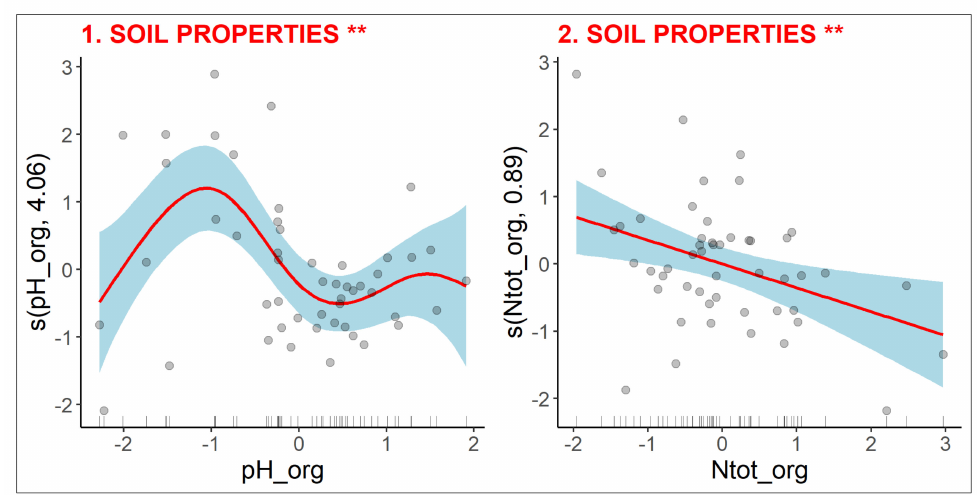
Figure 7. The estimated relationships between the diversity of leaf-height-seed traits and two explanatory variables included in the final GAM: pH of the organic soil layer and total nitrogen content in the organic soil layer. The order of predictors reflects their effect size and significance: ** p < 0.01. The confidence interval (95%) is indicated with the light-blue ribbon around each curve. For additional definition of predictors, see Table 1.